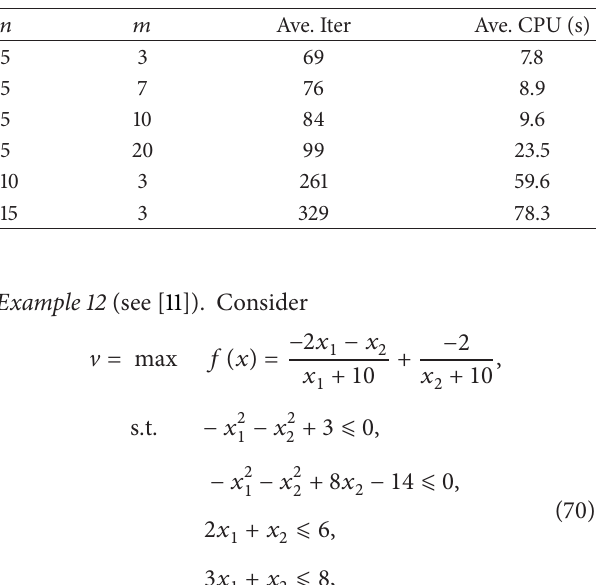
Table 2: Computational results of Example